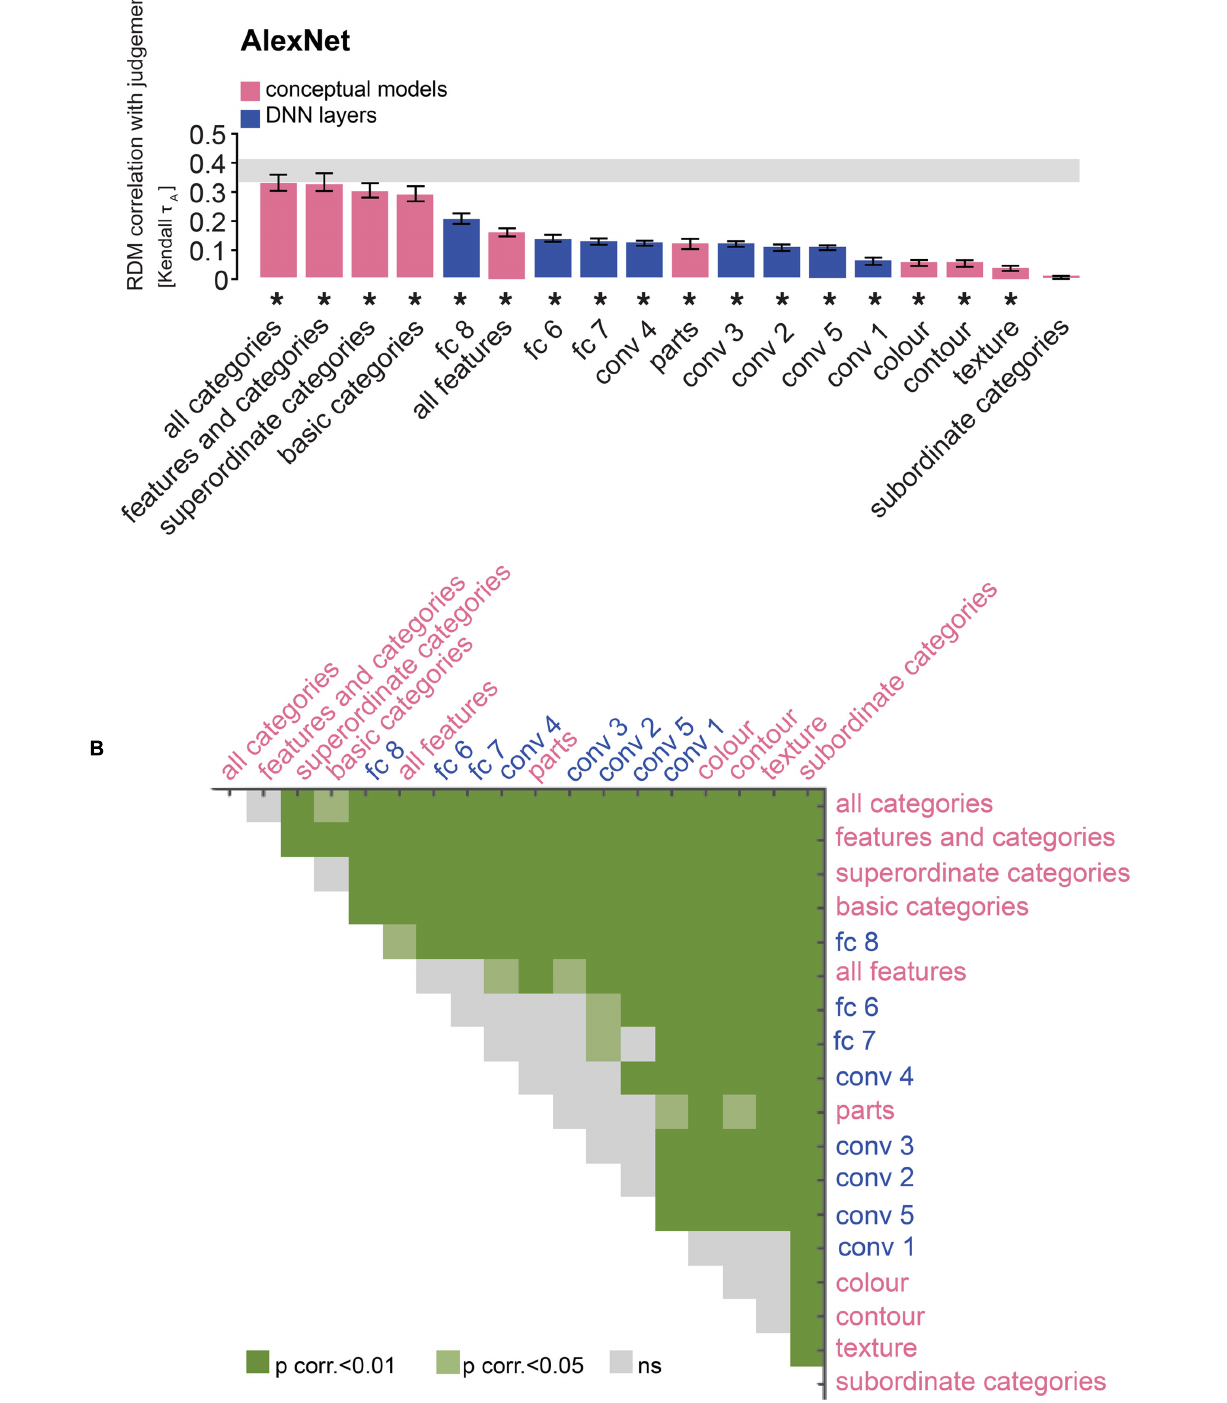
FIGURE 8 | Comparison of AlexNet and conceptual models: the last layer outperforms feature-based, but not categorical models. (A) Bars show the correlation between the similarity-judgment RDMs and each fitted AlexNet layer RDM, as well as each fitted conceptual model. Noise ceiling and significant correlations are indicated using the conventions in Figure 4 . (B) Pairwise differences between model performance of fitted AlexNet layer RDMs and conceptual models, using the same conventions as in Figure 4 .